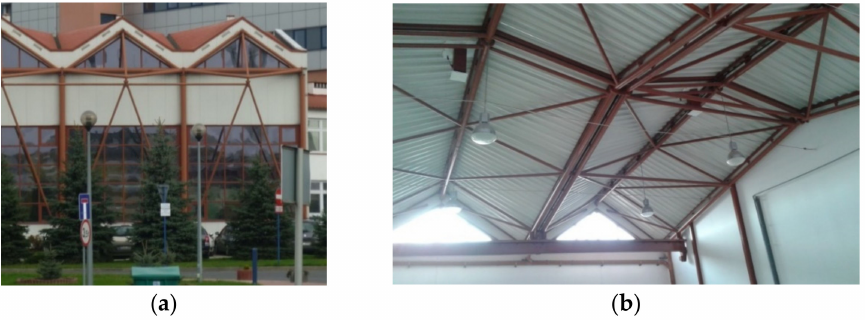
Figure 8. A roof shell structure composed of many transformed fold shell strips: ( a ) view from the outside; ( b ) view from the inside.